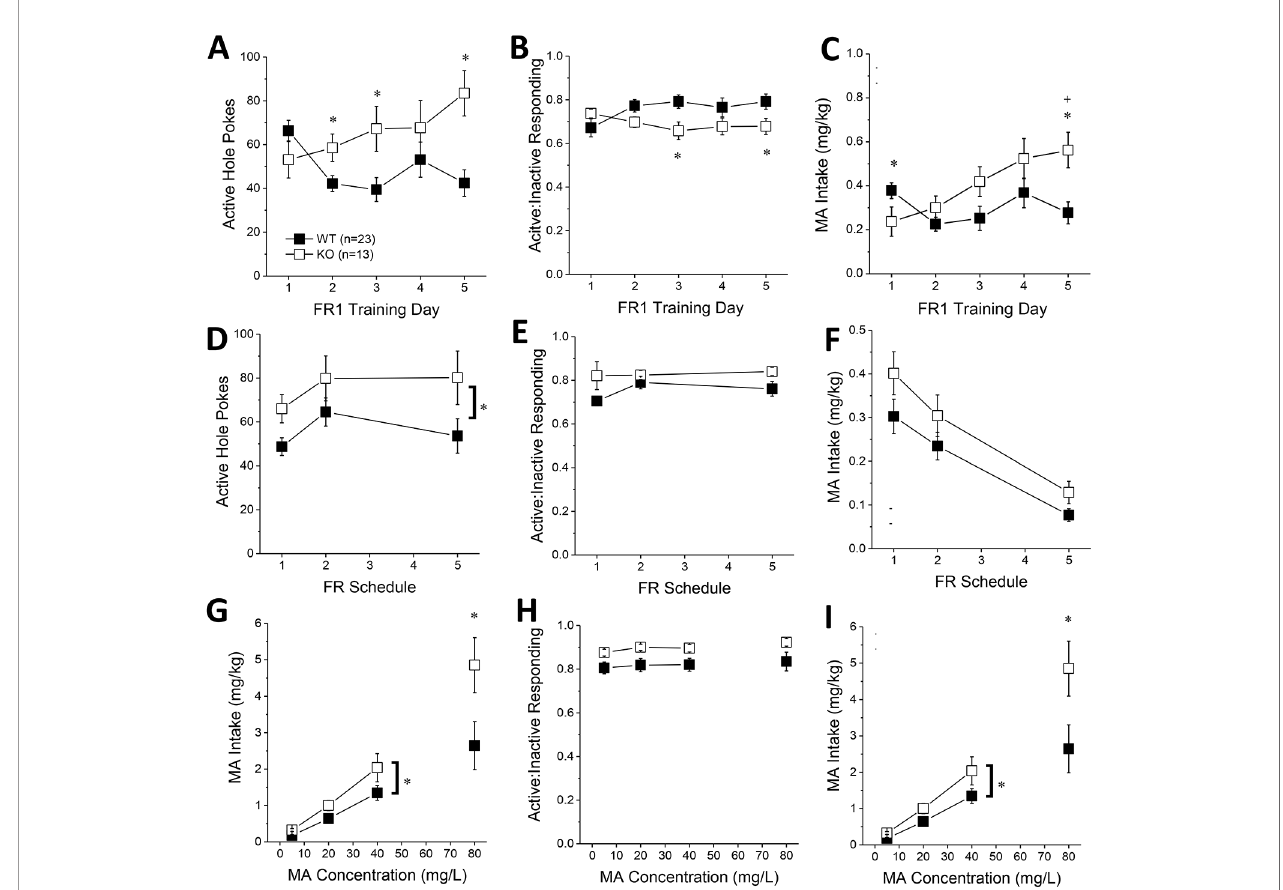
FIGURE 4 | Constitutive Homer2 deletion increases methamphetamine (MA) reinforcement and intake. When compared to WT mice, Homer2 knockout (KO) mice exhibited a greater: (A) the number of active nose pokes, (B) relative responding on the active versus inactive hole and (C) MA intake during the fi rst 5 days of self- administration training (10 mg/L MA as reinforcer). (D) Homer2 KO mice also exhibited more active hole responding under increasing response requirement but did not differ from WT mice regarding (E) response allocation or (F) MA intake during this phase of testing. Relative to WT mice, the dose-response function for active hole- responding was shifted upwards (G) , without a change in that for response allocation in the active hole (H) . (I) KO mice also consumed more MA than wild-type (WT) mice across the range of doses tested. The data represent the means ± SEMs of the number of mice indicated in Panel A . *p < 0.05 vs. WT (main Genotype